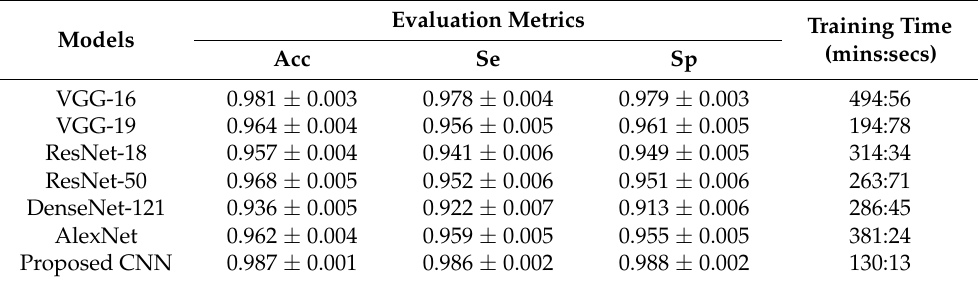
Table 9. The results of different models on the testing set in the RS dataset + DCGAN dataset during the 10-fold cross-validation (mean ± standard